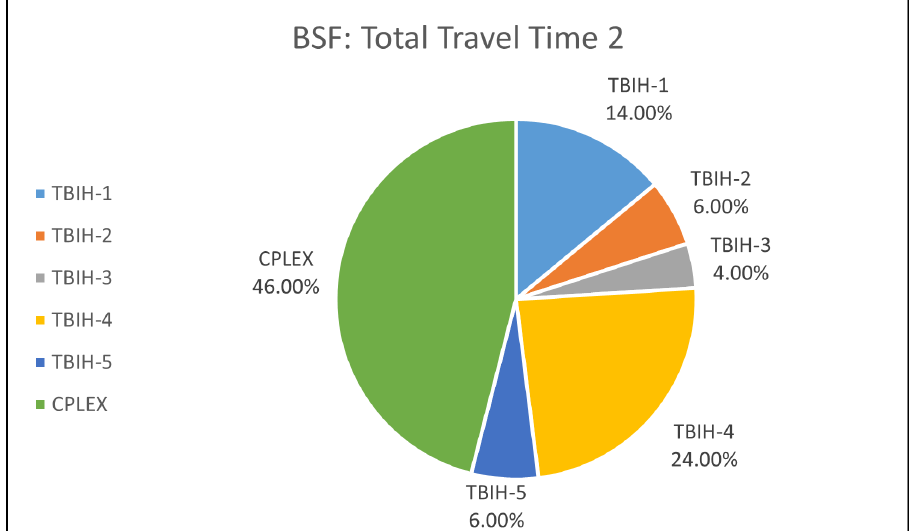
Figure A25. Algorithms performance compared to matheuristic rollout applied in PDS-RA: total BSF measured for total travel time over all test instances applied (including 10 non-benchmarked